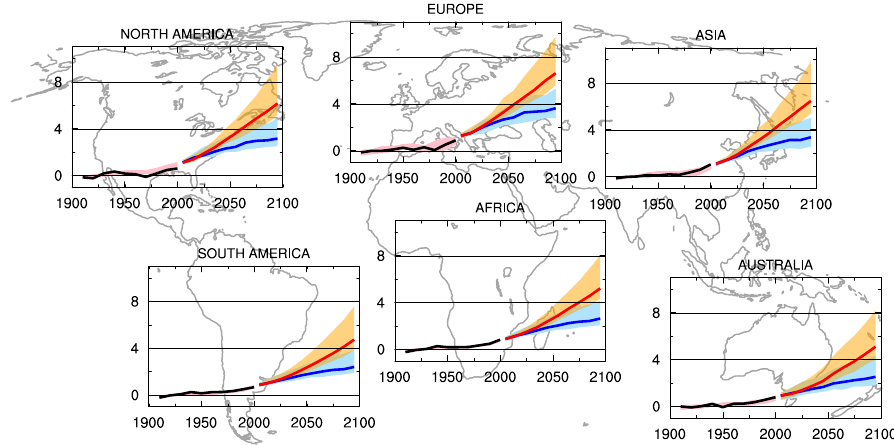
Fig. 14. Decadal mean continental surface air temperature anomalies ( ◦ C) from the 1901–1950 mean for the IGSM-CAM simulations (from 1906 to 2100) and for the HadCRUT4 (from 1906 to 2005). The black lines represent the observations and the pink bands show the range of temperature anomalies among all the historical IGSM-CAM simulations. The blue and orange bands show the range of temperature anomalies for the REF and L2S scenarios among all the IGSM-CAM simulations. The red and blue lines show the mean of the five-member ensemble IGSM-CAM simulations under the median climate sensitivity. From 1906 to 2005, the decadal averages are centered on the decade boundaries, whereas for the future period they are centered on the decade